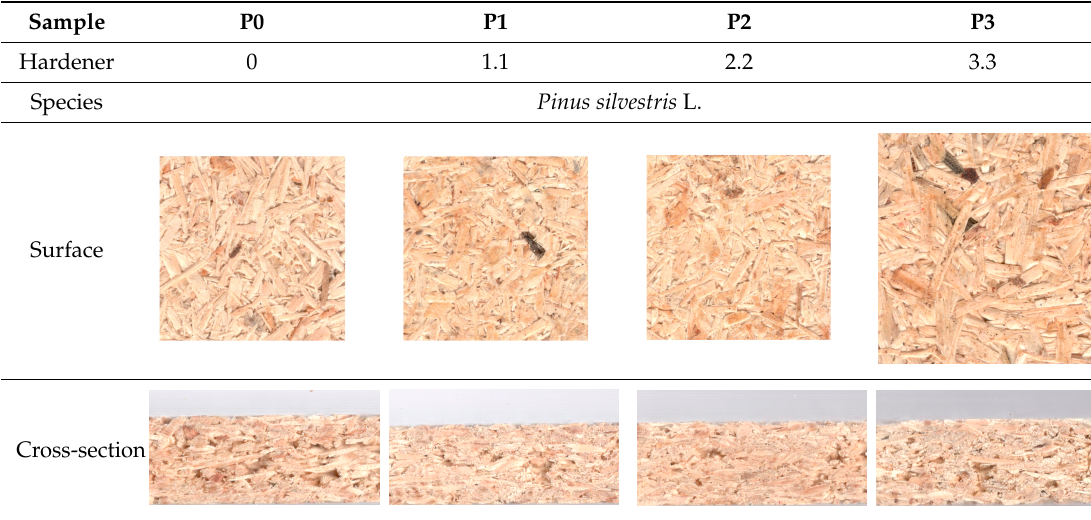
Table 4. Sample appearance of the boards made of oak.